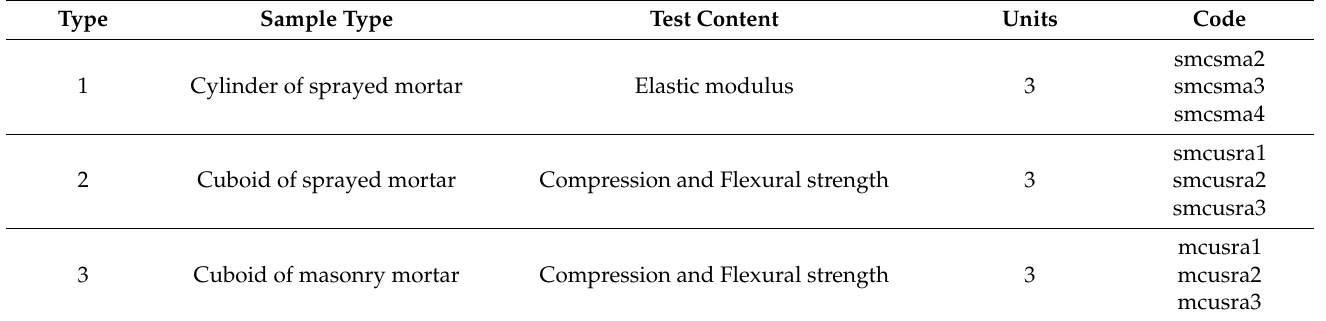
Table 3. Property test samples’ main characteristics.